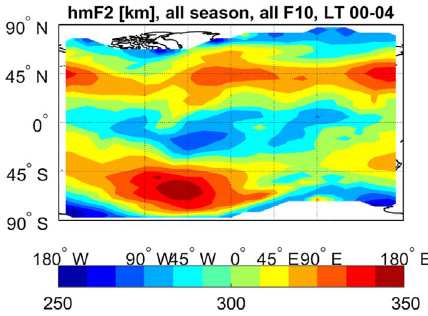
Fig. 19. Global map of the peak electron density height hmF2 averaged over all seasons at night (00 – 04 LT).